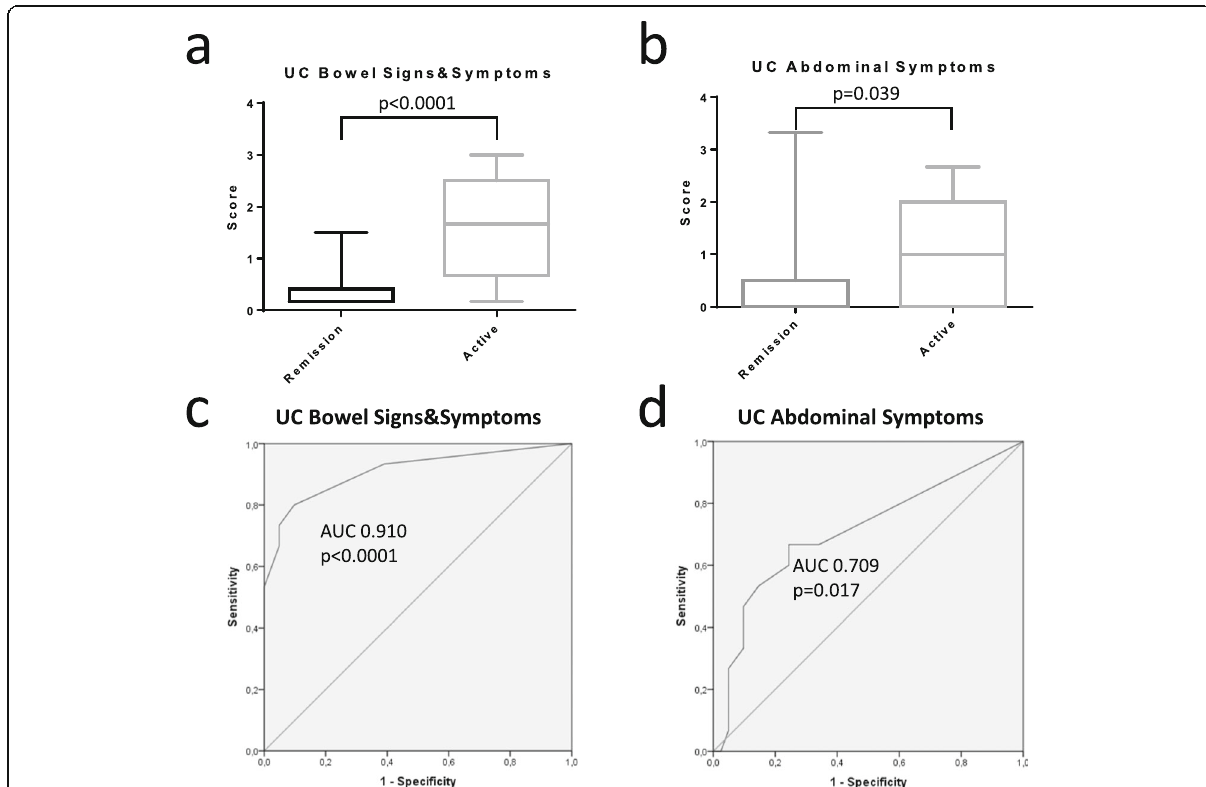
Fig. 2 UC bowel signs and symptoms ( a ) and abdominal symptoms ( b ) measures of patients defined in clinical remission or suffering from disease relapse (active) by global clinical assessment. ROC curves of UC bowel signs and symptoms ( c ) and abdominal symptoms ( d ) referred to disease activity status by global clinical assessment. Statistical significance of differences (p value) is reported in the plot area. AUC: area under the curve. (ns) not